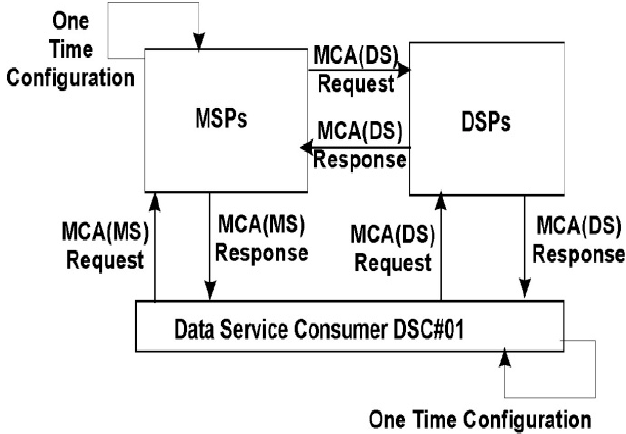
Figure 3. SDRest System Architecture for One Time Configuration (OTC).